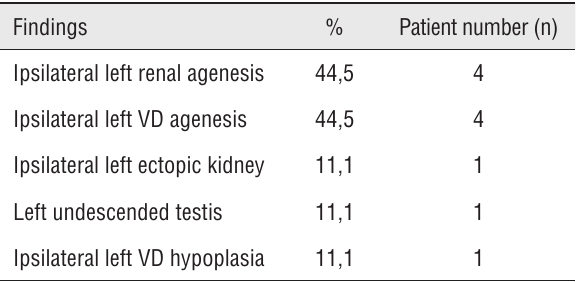
Table 1 - Genitourinary system abnormalities accompanying unilateral left sv